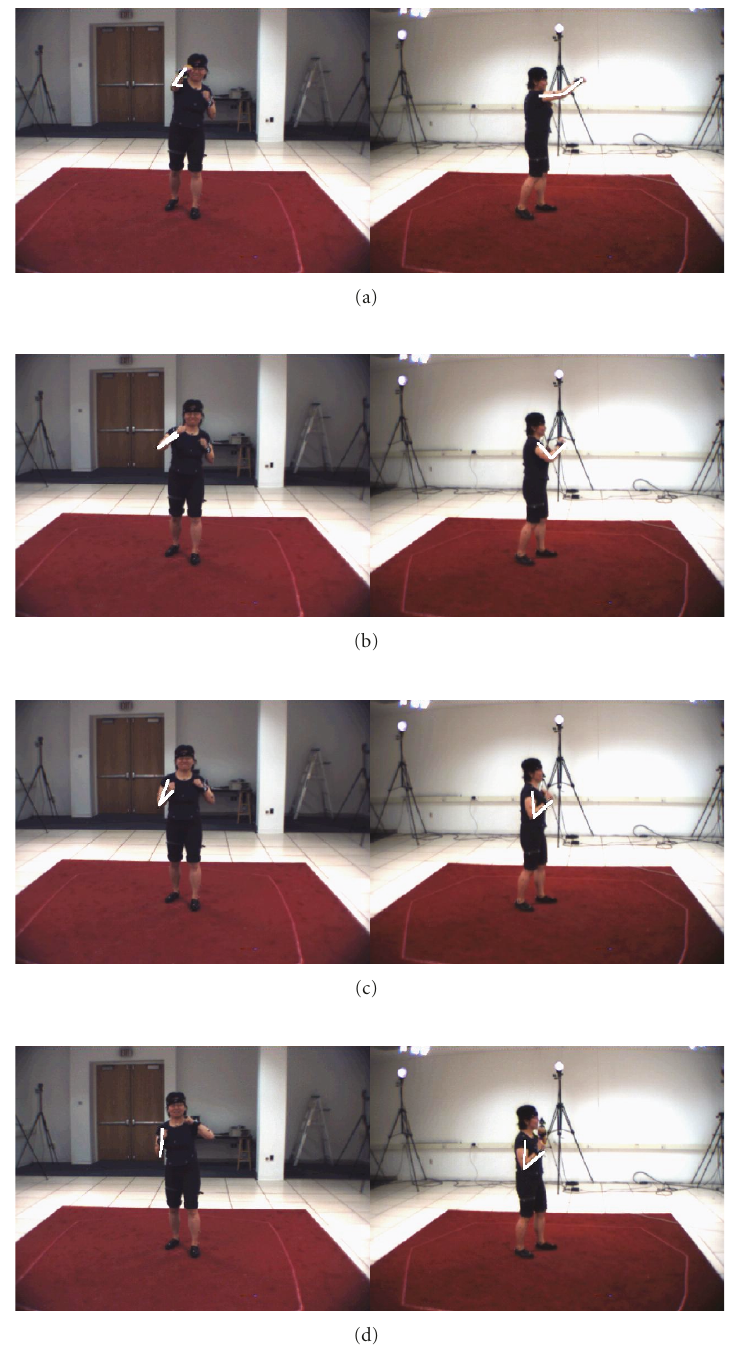
Figure 11: HumanEva box sequence for the subject 1, applying Inverse kinematics using image-based constraints.